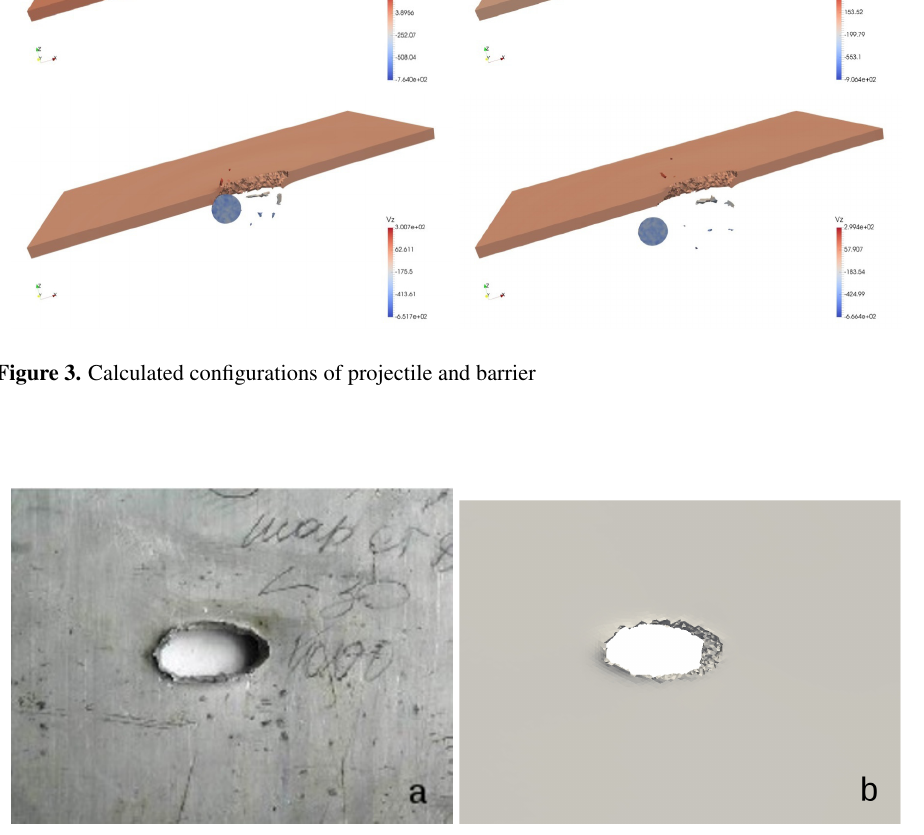
Figure 4. View of barrier after interaction with projectile: a) – experiment, b) –